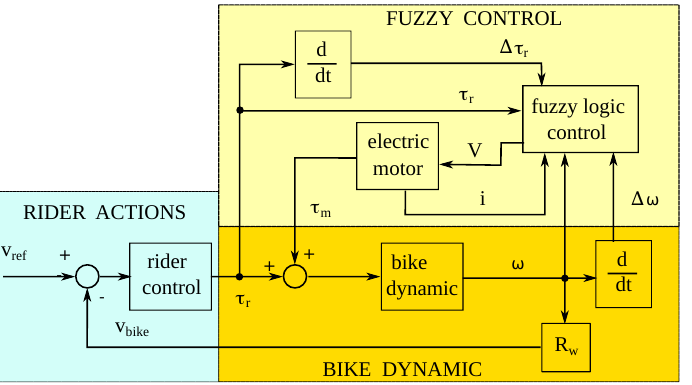
Figure 31. Scheme of the fuzzy control system [72].